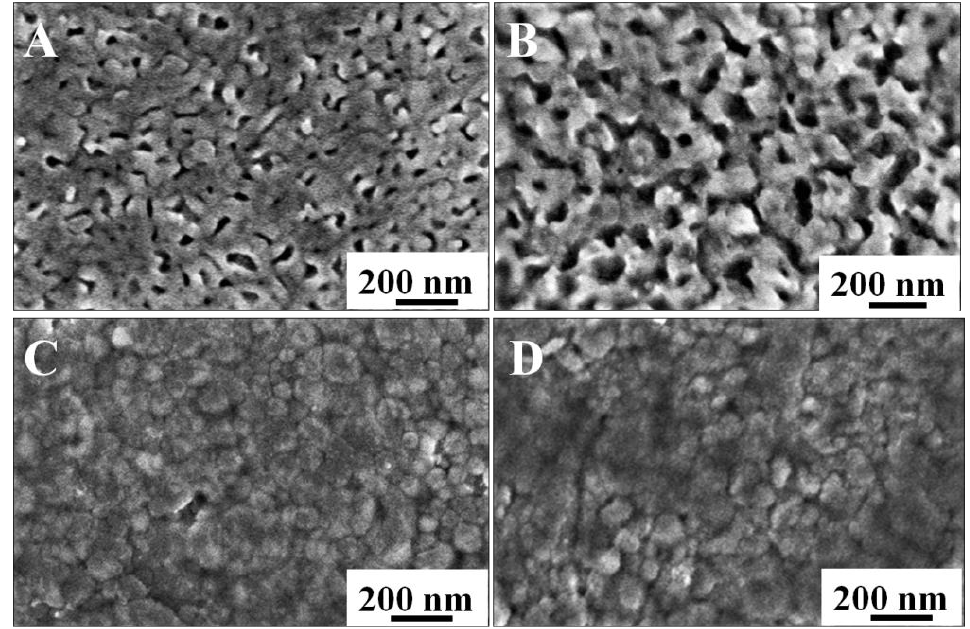
Figure 5. Morphology of Mo-BVO and Mo-BVO (C) before and after 4h and 10 h J-T measurements, respectively. ( A ) Before Mo-BVO. ( B ) After Mo-BVO. ( C ) Before Mo-BVO (C). ( D ) After Mo-BVO Mo-BVO. ( B ) After Mo-BVO. ( C ) Before Mo-BVO (C). ( D ) After Mo-BVO (C).